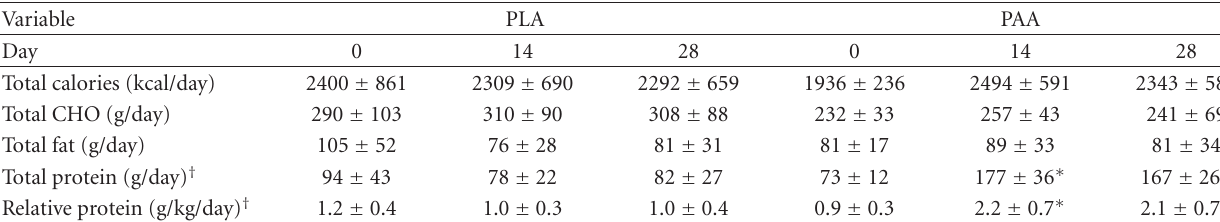
Table 2: Dietary values assessed prior to the three testing sessions for placebo (PLA) and protein/amino acid (PAA) groups. All data are presented as mean ± standard deviation. Results indicated a significant di ff erence between groups at days 14 and 28 for total protein and relative protein ( P < 0 . 001) and a significant change from baseline over time for the PAA group ( P < 0 . 001). ∗ Denotes a significant time e ff ect and † denotes a significant di ff erence between groups.